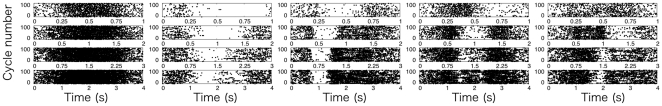
Spike patterns of 5 representative granule cells shown in

Figure 2B

for 100 cycles of MF signal oscillation with frequencies of 1 Hz, 0.5 Hz (default), 0.33 Hz and 0.25 Hz (top to bottom, respectively). Abscissa represents the duration of a cycle, so that the duration varies at 1, 2, 3 and 4 s, respectively. Throughout the test frequencies, similar spike patterns are generated while temporally expanded or compressed.